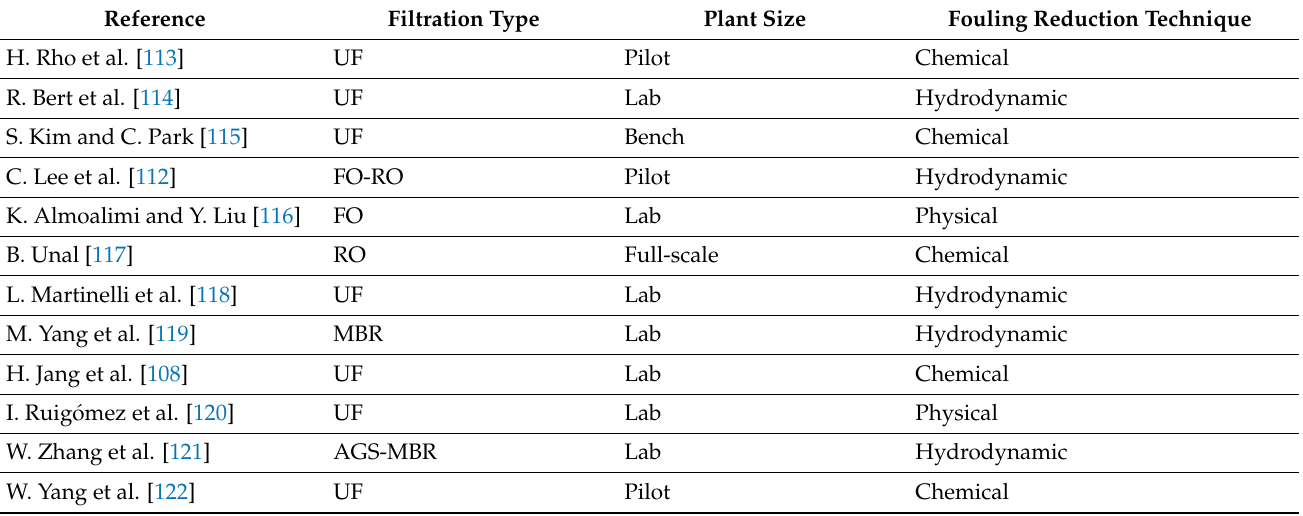
Figure 4. Membrane fouling control. Table 4. Fouling reduction